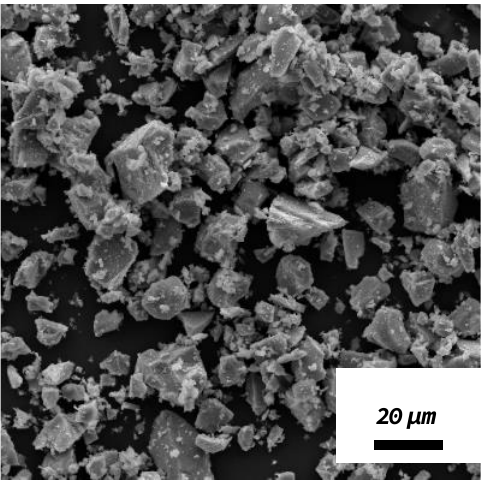
Fig. 1. SEM image of the TiC